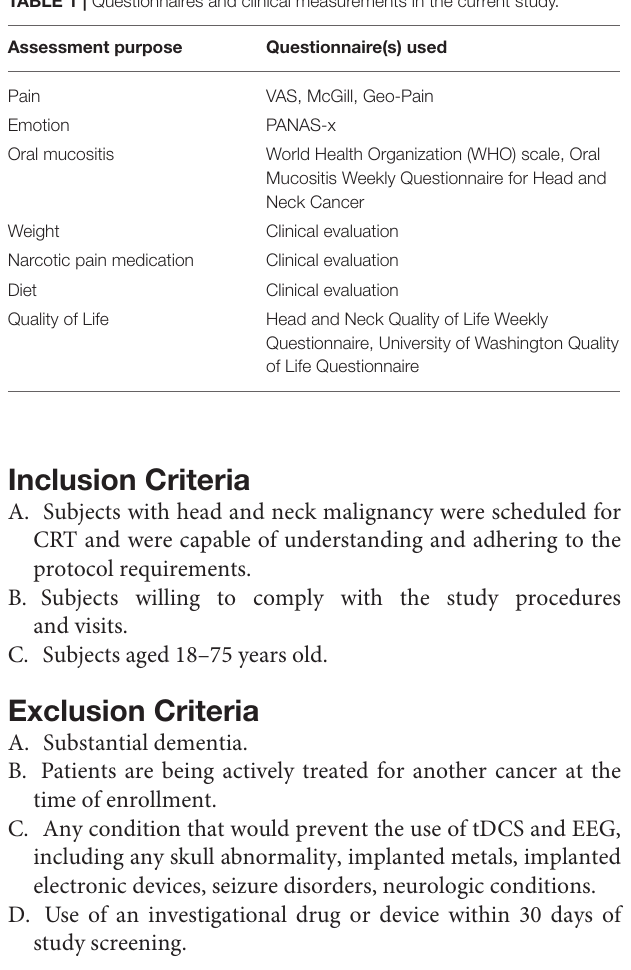
TABLE 1 | Questionnaires and clinical measurements in the current